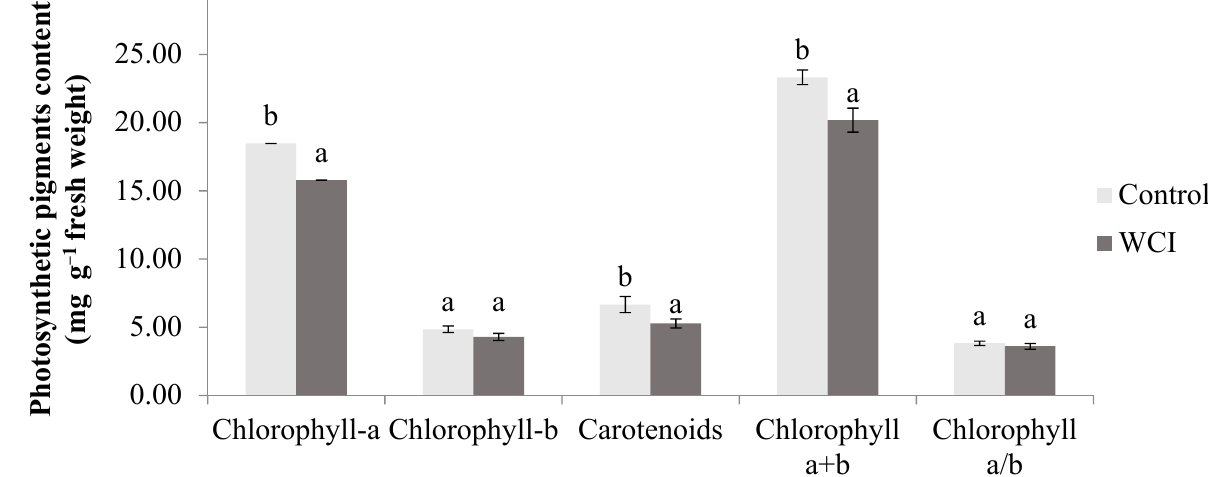
Figure 2. The effects of woolly cupgrass infestation (WCI) on the individual leaf photosynthetic pigments (chlorophyll-a, chlorophyll-b, and carotenoids) of the fourth (14 d.a.s.) maize leaf (values represent means ± SD, n = 10). Small letters (a, b) show significant differences between treatments based on independent t-test ( p < 0.05).